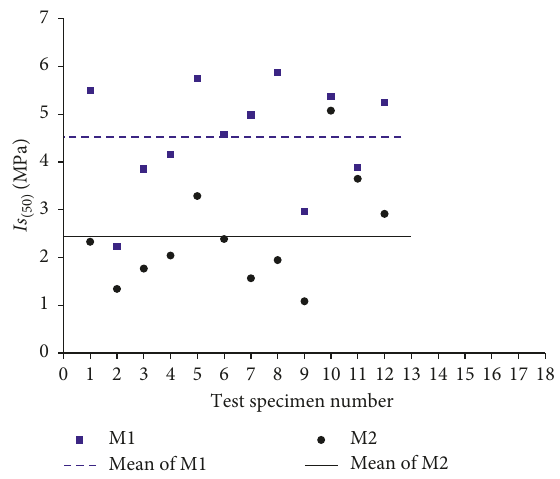
Figure 3: The results of Is ( 50 ) using various calculation